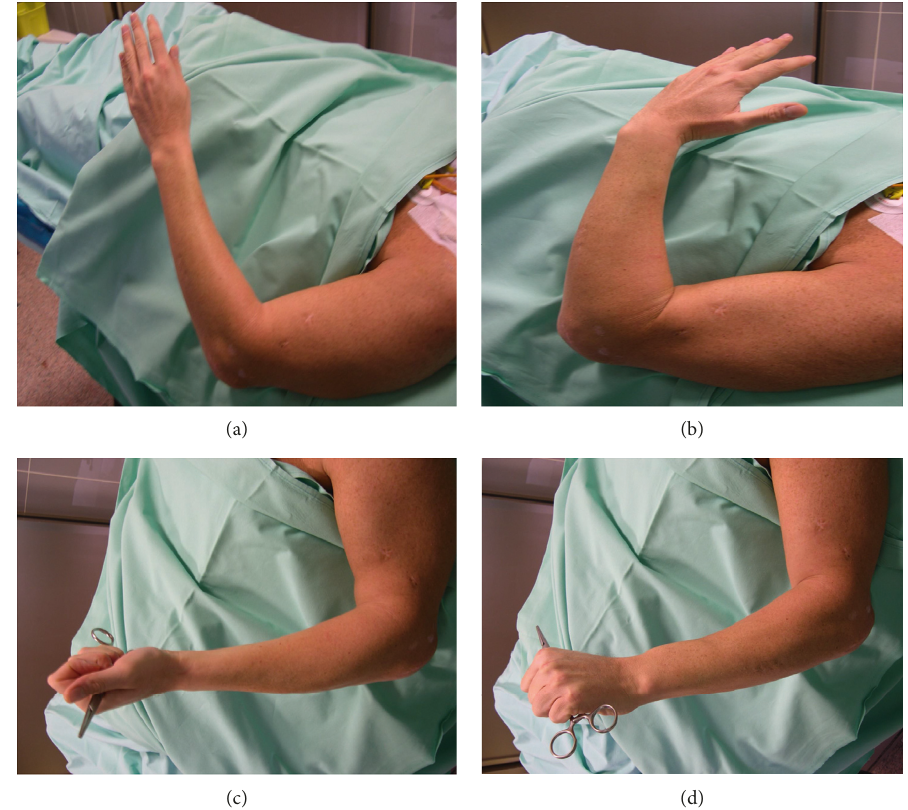
Figure 4: Preoperative situation and active elbow range of motion. Maximum of 80 degrees of flexion (a); no possibility of extension (b); sufficient pronation and supination (c, d).